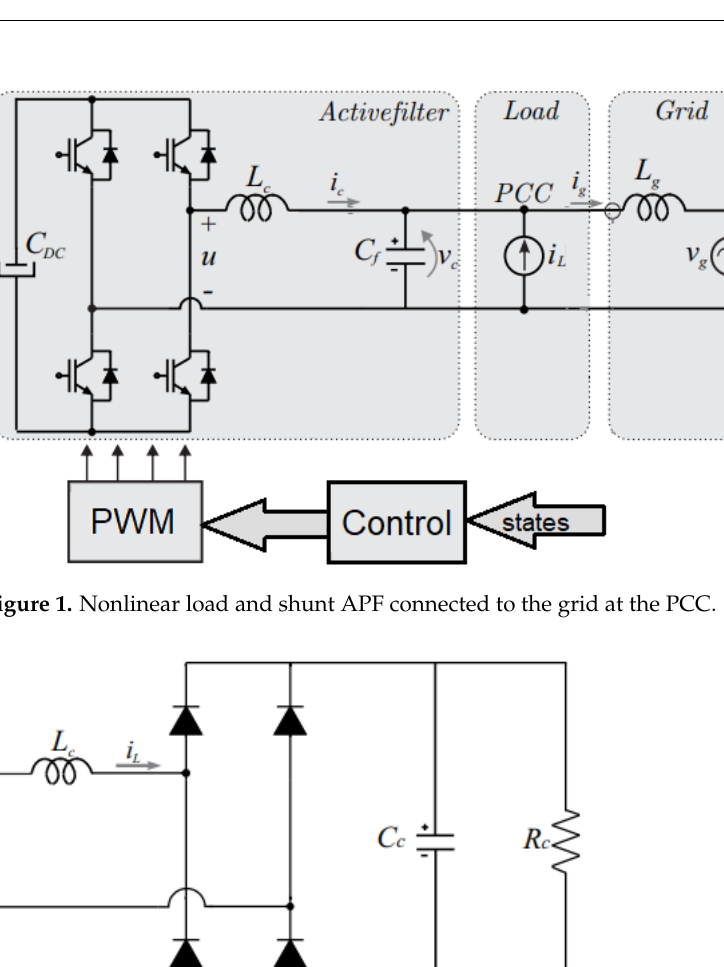
Figure 2. Single-phase standard nonlinear load (Rectifier load). Note that there is no restriction on the value of R c . the value of R c . Table 1. Parameters of the system under